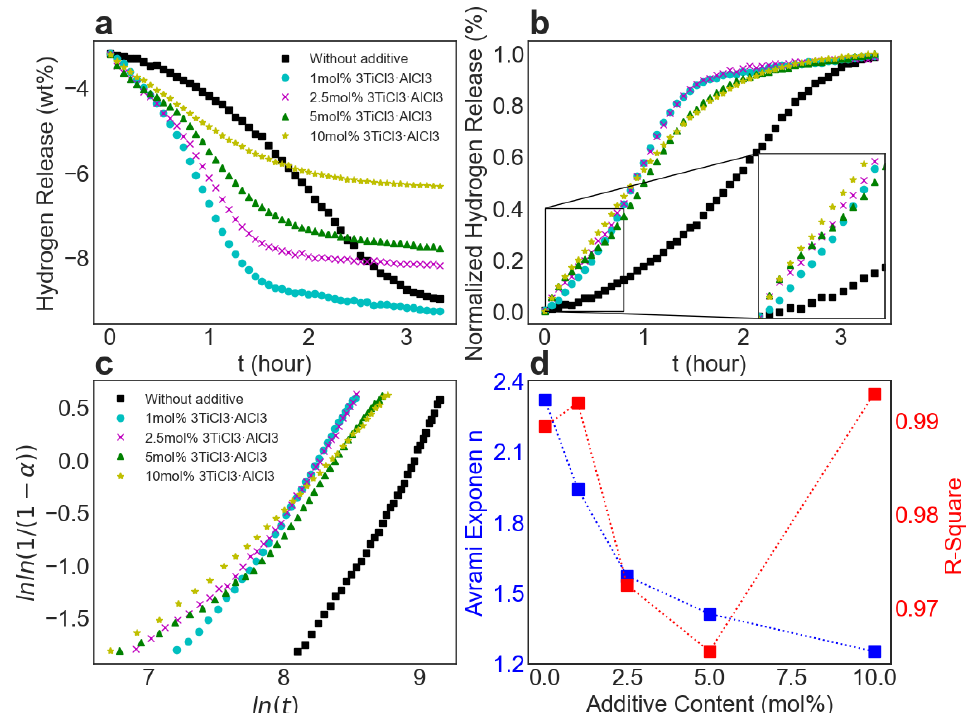
Figure 6. Analysis of the dehydrogenation kinetics with varying contents of additive: ( a ) Hydrogen release over time relating to the second dehydrogenation step for varying contents of additive; ( b ) Min – max normalization of the image ( a ); ( c ) JMAK plots of lnln( 1 vs. ln ( t ) with α ranging from 15% to 85% based on the image ( b ); ( d ) Change in the Avrami exponent n (left blue axis) and corresponding R-square (right red axis) with the increase of additive content.